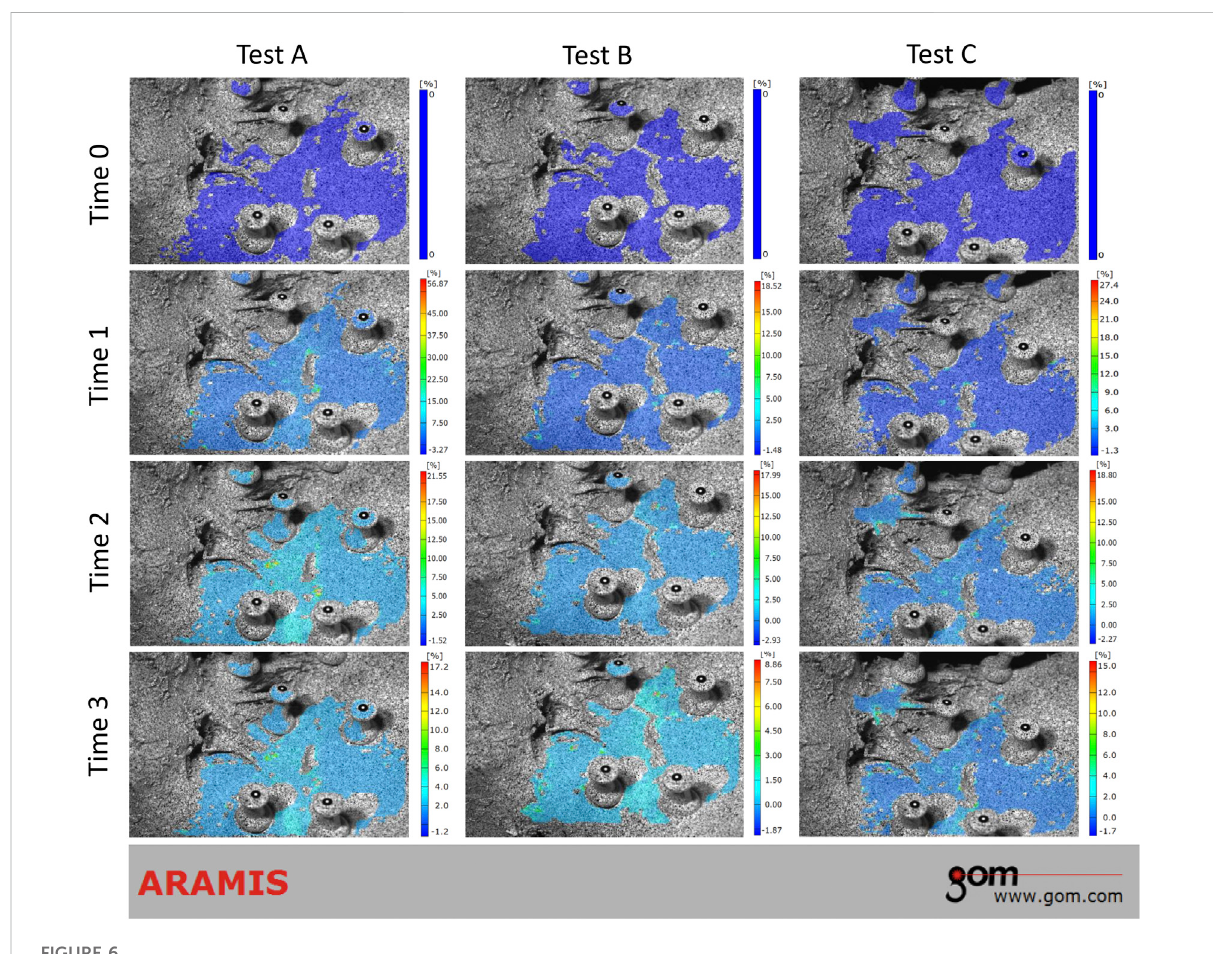
FIGURE 6 Straintrendoftheunstablesacroiliacjointwithinjuredpubicsymphysisunderthreetests(loadingphase).Time0showedtheoriginalcondition without any load. Time 1 and 2 showed the process of loading. Time 3 showed the ending condition with